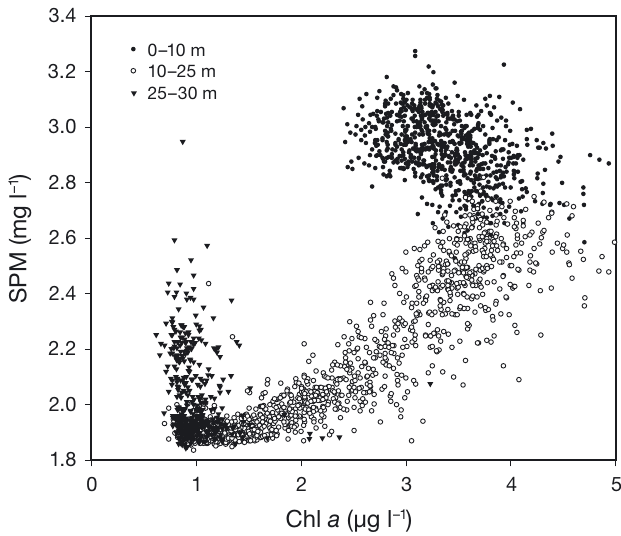
Fig. 8. Relationships between chlorophyll a (chl a) and sus- pended particulate matter (SPM) concentrations over 3 depth ranges beside a salmon net-pen at the Rataran